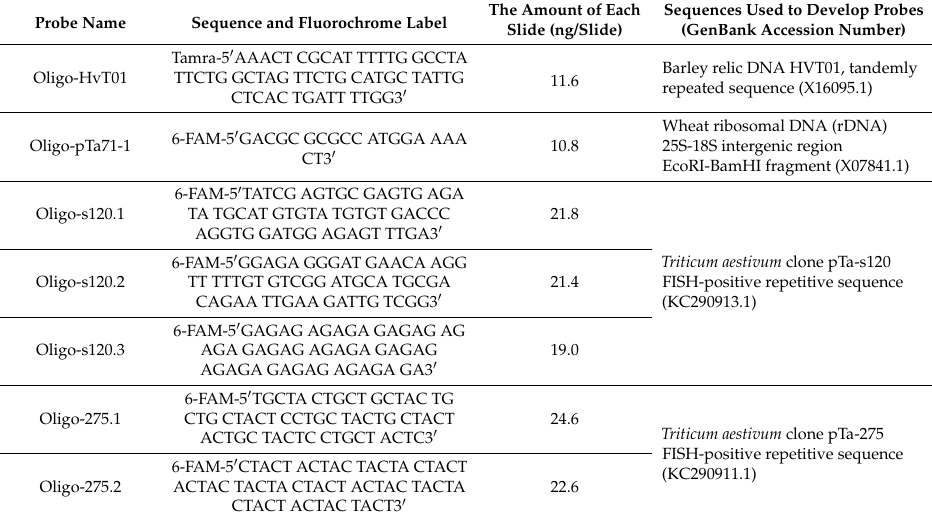
Table 1. Name, sequence, applied amount and sources of oligonucleotide probes for Fluorescence in situ hybridization (FISH)